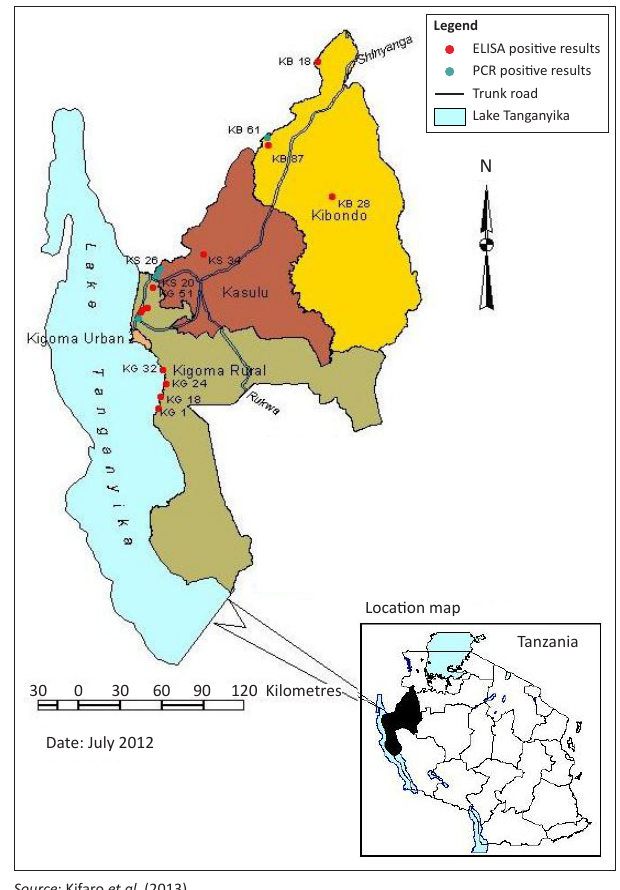
Source : Kifaro et al . (2013) FIGURE 1: Map of Kigoma region showing the three districts where some of the Rift Valley fever virus-positive sheep and goats were identified.